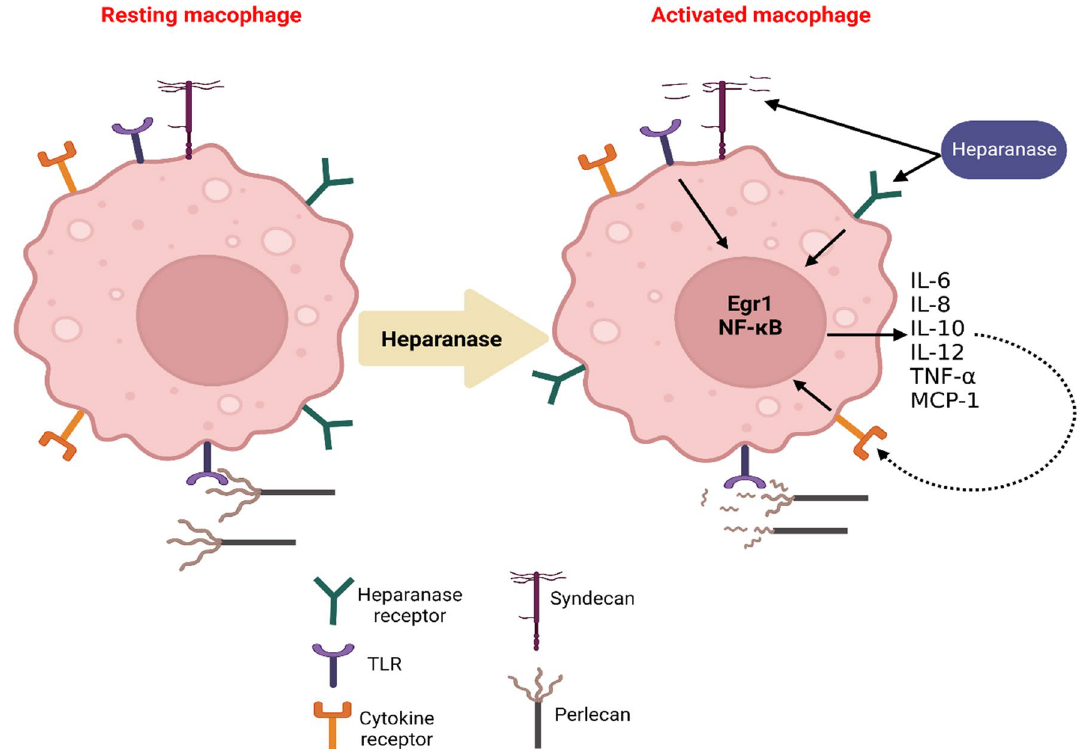
Fig. 2 Heparanase (HPSE) and macrophage activation: HPSE activates resting macrophage to be converted to activated macrophage with activation of cytokine receptors. HPSE via HPSE receptors increases expression of Fgr1 and NF‑κB which induces expression and release of pro‑inflammatory cytokines like IL‑6 and IL‑2. HPSE and pro‑inflammatory cytokines also stimulate the activated macrophage to release more of pro‑inflammatory